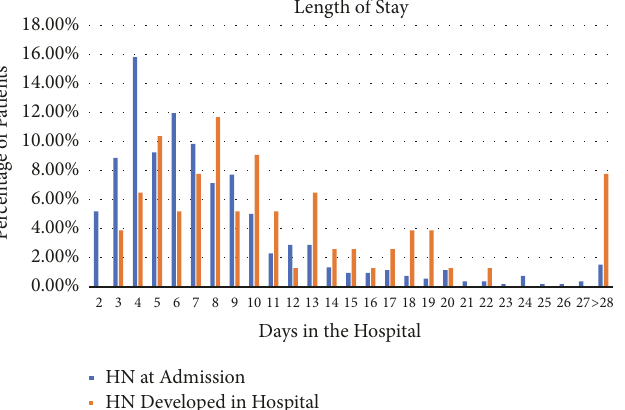
Figure 2: The distribution of length of stay (LOS) for patients with hyponatremia (HN) at admission versus those who developed HN during